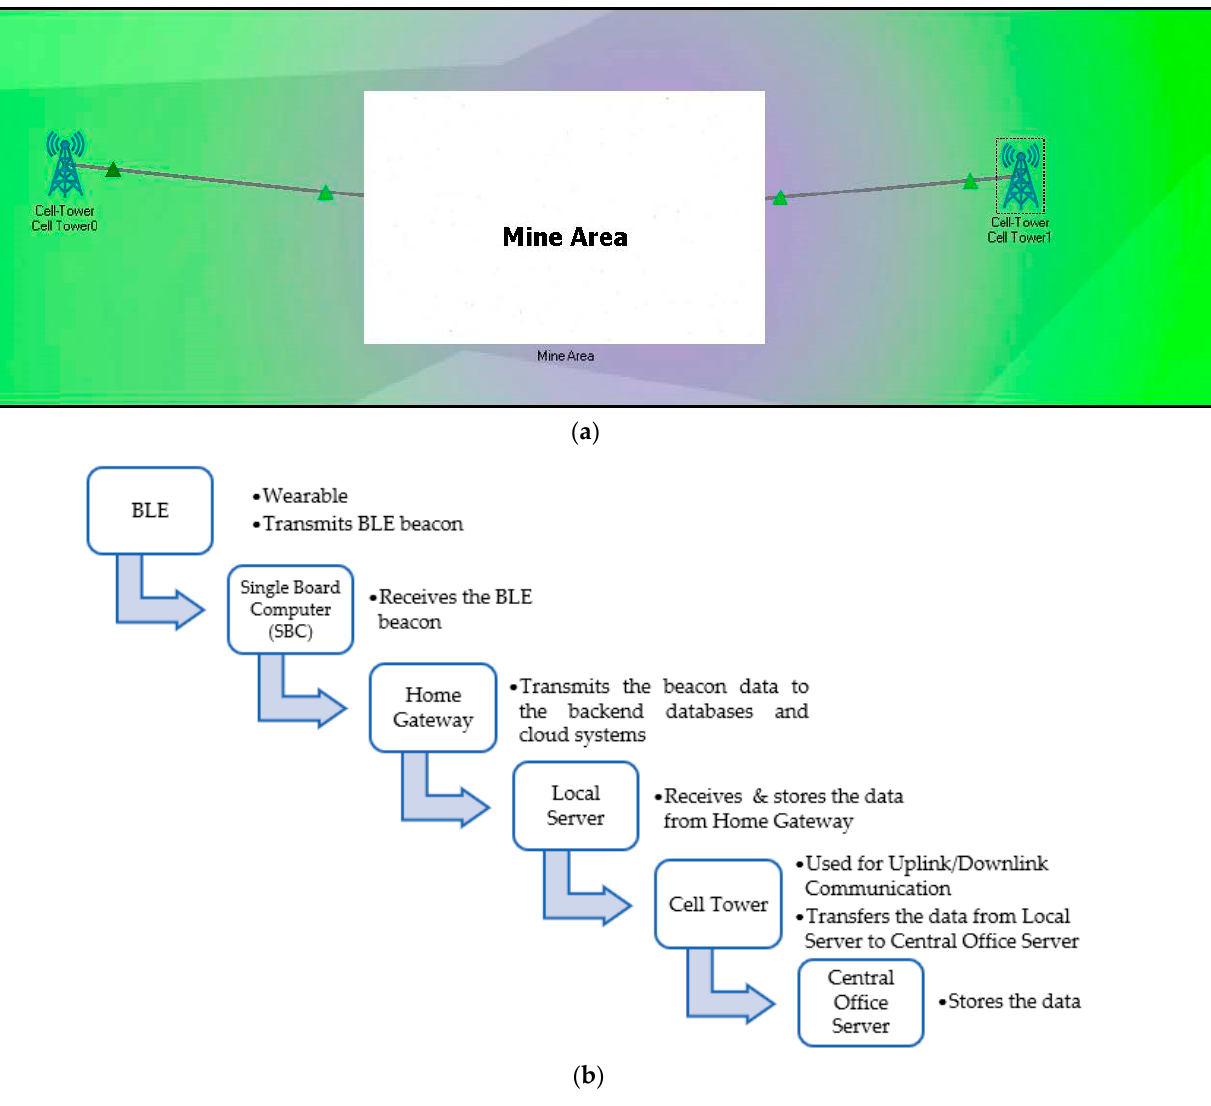
Figure 7. Proposed system architecture and workflow. ( a ) Proposed System Model; ( b ) Complete Workflow Process.